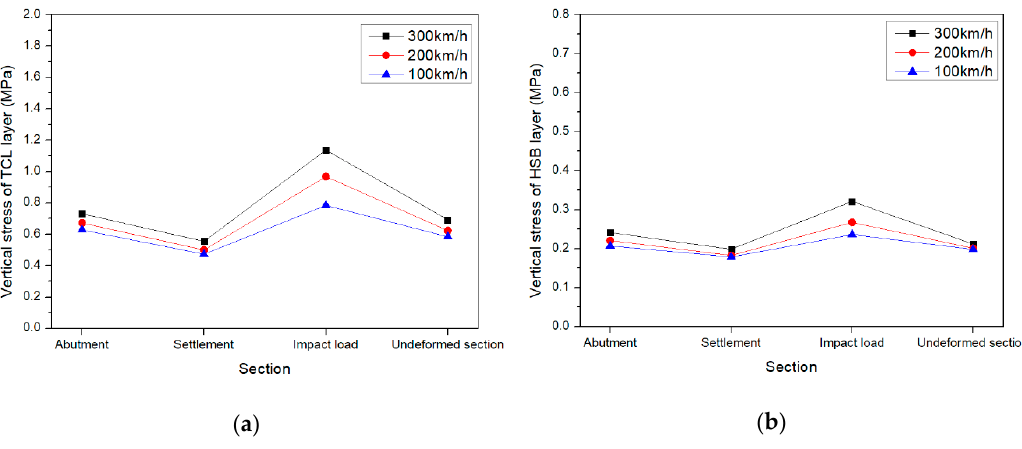
Figure 19. Vertical stresses of the concrete slab track. ( a ) Track concrete layer (TCL) layer; ( b ) Hydraulically stabilized base (HSB) layer.